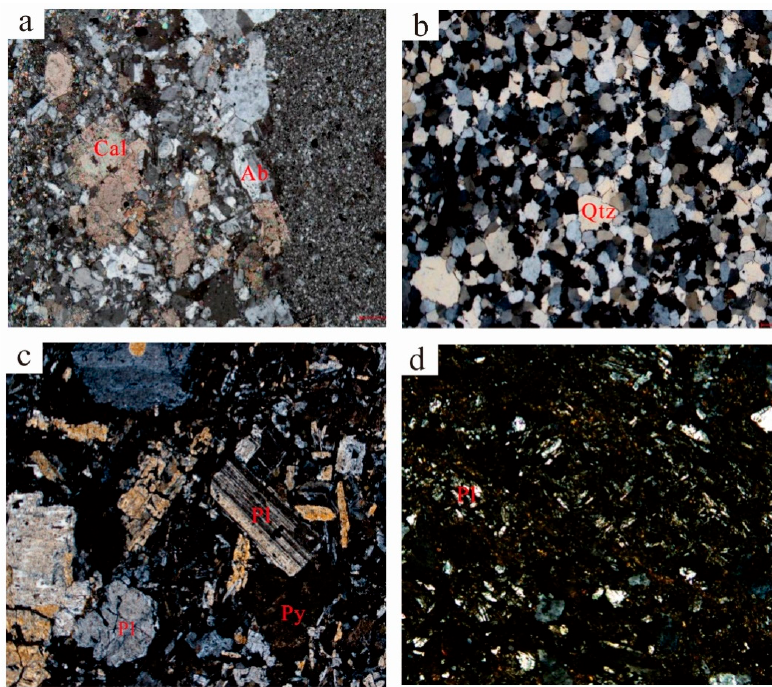
Figure 4. ( a ) Gravel structure, (+) 10 × 4; ( b ) medium coarse-grained quartz sandstone (+) 10 × 2; ( c ) porphyritic structure, (+) 10 × 2; and ( d ) tuff texture, (+) 10 × 5 (Ab = albite; Cal = calcite; Pl = plagioclase; Py = pyroxene; Qtz = quartz).